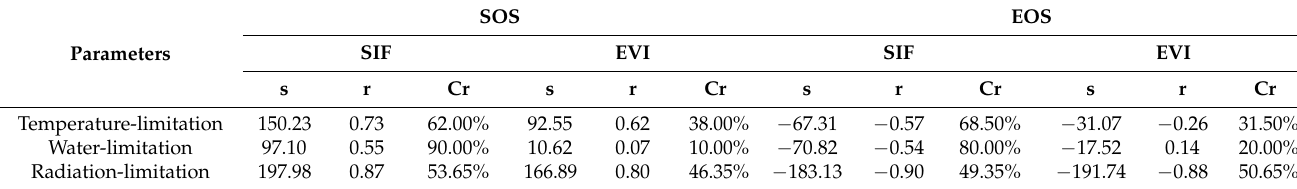
Table 1. The relationships between phenology from SIF or EVI and climatic limitation indices. s: slope of the linear regression between phenology from SIF or EVI and climatic limitation indices. r: correlation coefficient of the linear regression. Cr: contribution ratio of phenology from SIF or EVI to the difference of phenology derived from SIF and EVI under climatic